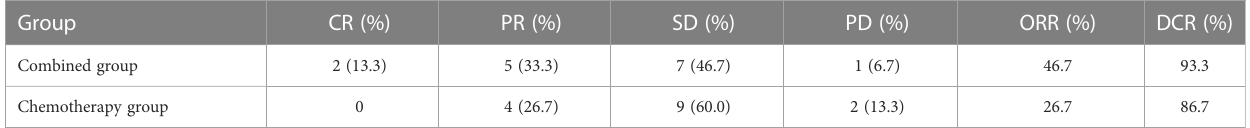
TABLE 2 Comparison of two groups after neoadjuvant therapy. Group CR